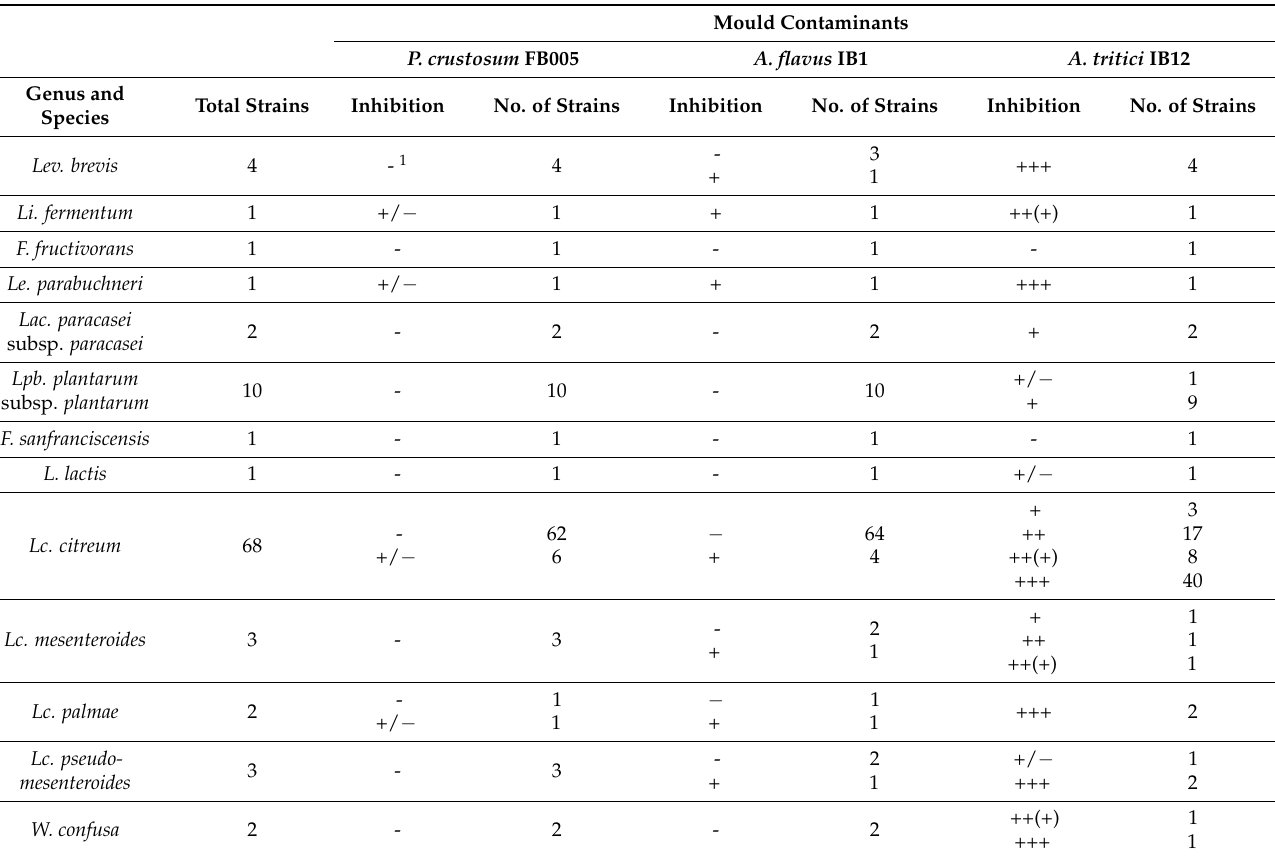
Table 3. Antifungal activities of 99 LAB strains determined on WFH medium against P . crustosum FB005, A. flavus IB1, and A. tritici IB12 all isolated from soft rolls. Numbers in rows represent numbers of antifungal strains; zones of inhibition (halo measured from edge of colony to edge of zone of inhibition): +++ = complete inhibition of fungi; ++(+) = > 5 mm with minor fungi growth; ++ = 2.5–4.9 mm; + = 0.1–2.4 mm; +/- = no halo but a brightening of the medium; and - = no inhibition. If inhibition was detected in the single run, screening was performed in